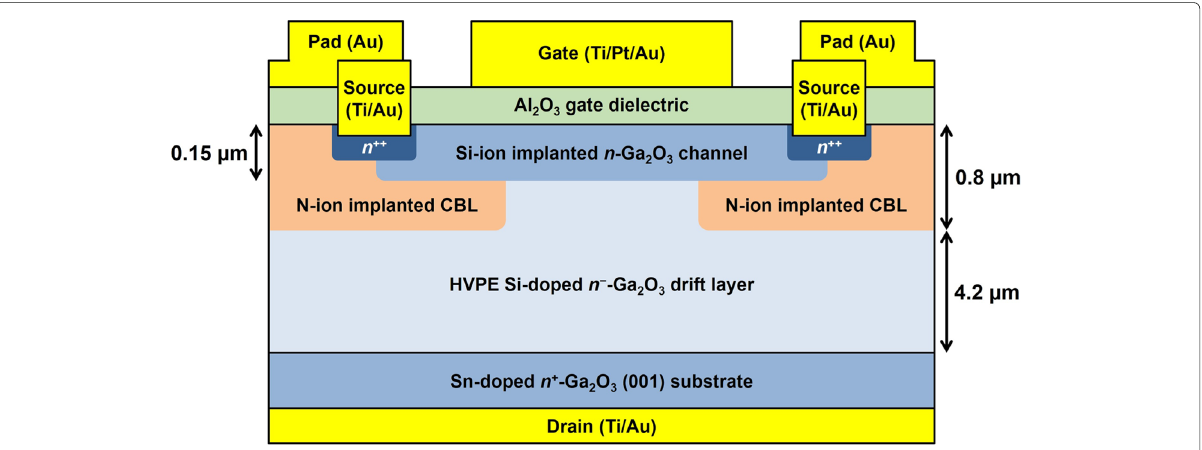
Fig. 14 Schematic cross section of vertical D-mode Ga 2 O 3 FET with current aperture. Adapted with permission [97]. Copyright 2019, IEEE